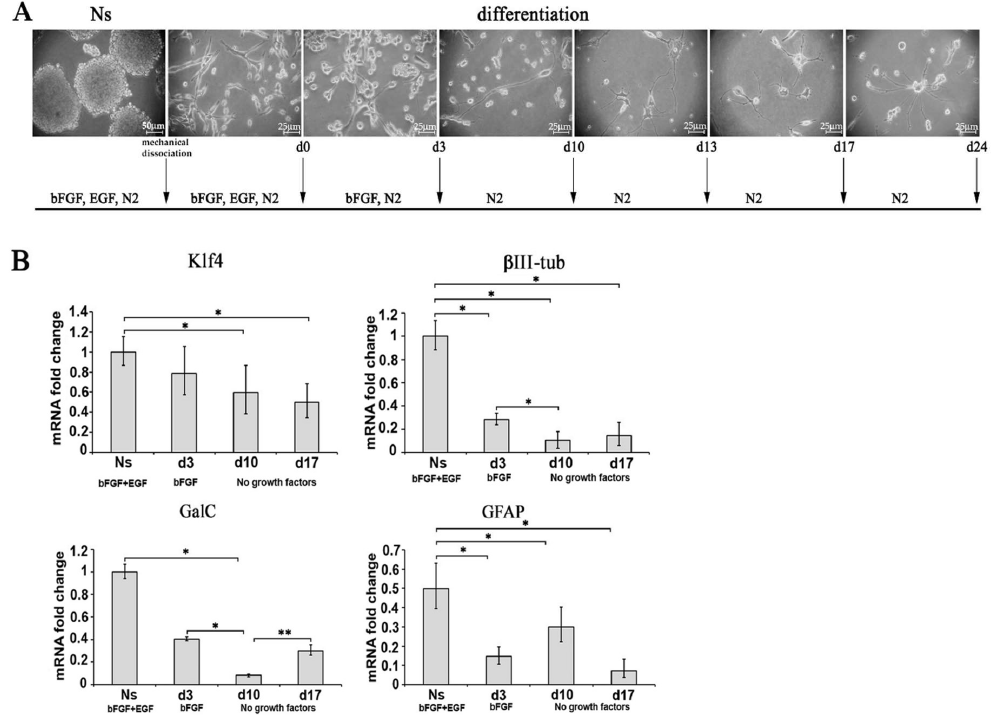
Figure 3. Characterization of diff-Ns cells by real-time PCR. ( A ) A1 cells derived from the mechanical dissociation of